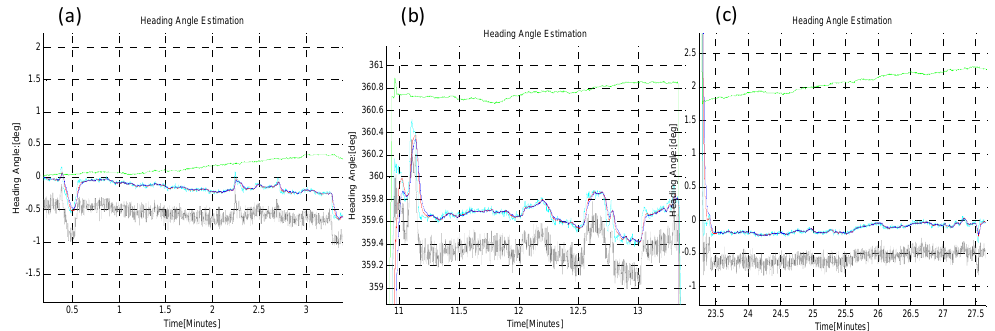
Figure 14. Zoom ‐ in view of heading angle, ( a ) at start; ( b ) in middle and; ( c ) at the end of test.